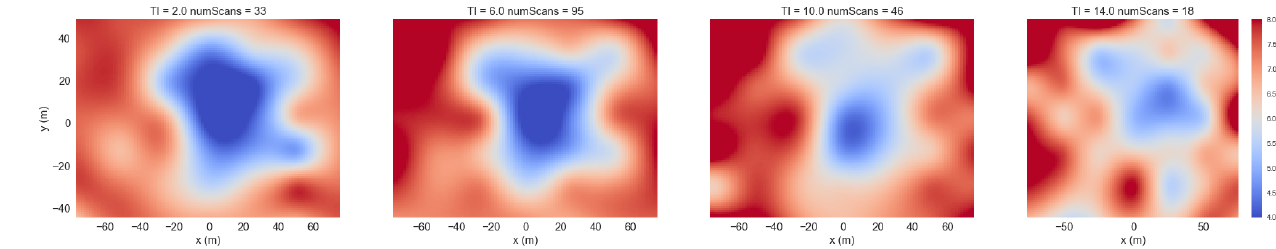
Figure 3. Lidar data at 180.95m downstream at different turbulence intensities ranging from 2.0% to 14.0%. The title of each plot indicates the turbulence intensity and the number of scans used to produce each time-averaged